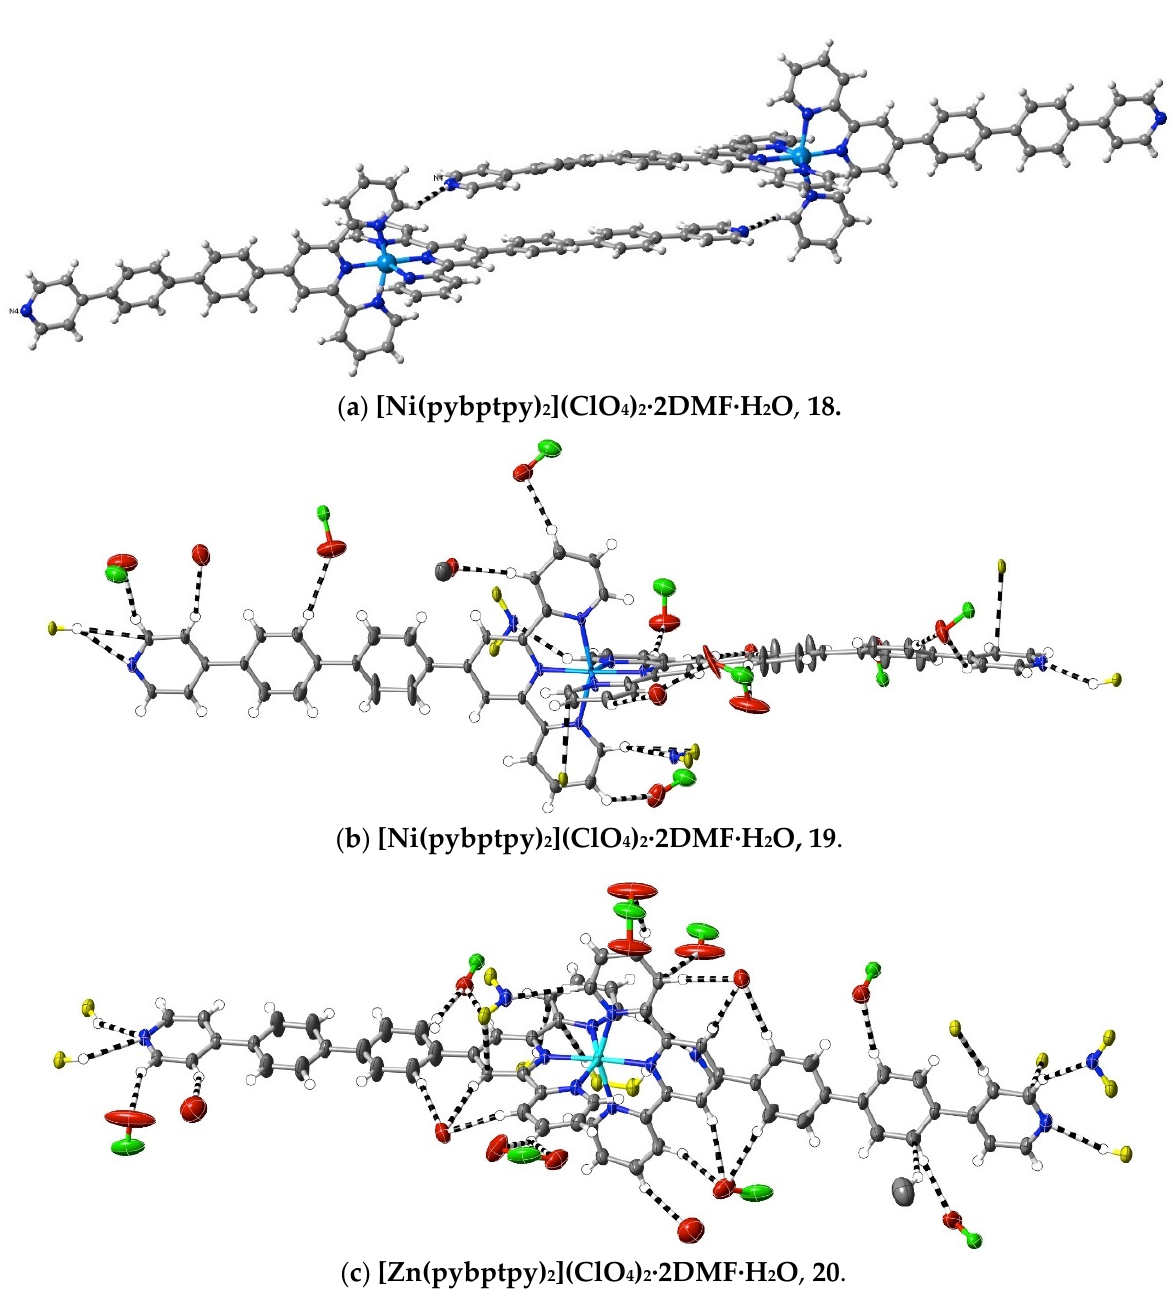
Figure 7. Interactions exceeding dispersion in complexes of pybptpy, showing, ( a ) in the Ni(II) complex as an example, a partial view of the stacking, which appears to be reinforced by N ... HC interactions, and ( b – c ) the full range of cation interactions in the Ni(II) and Zn(II) complexes.